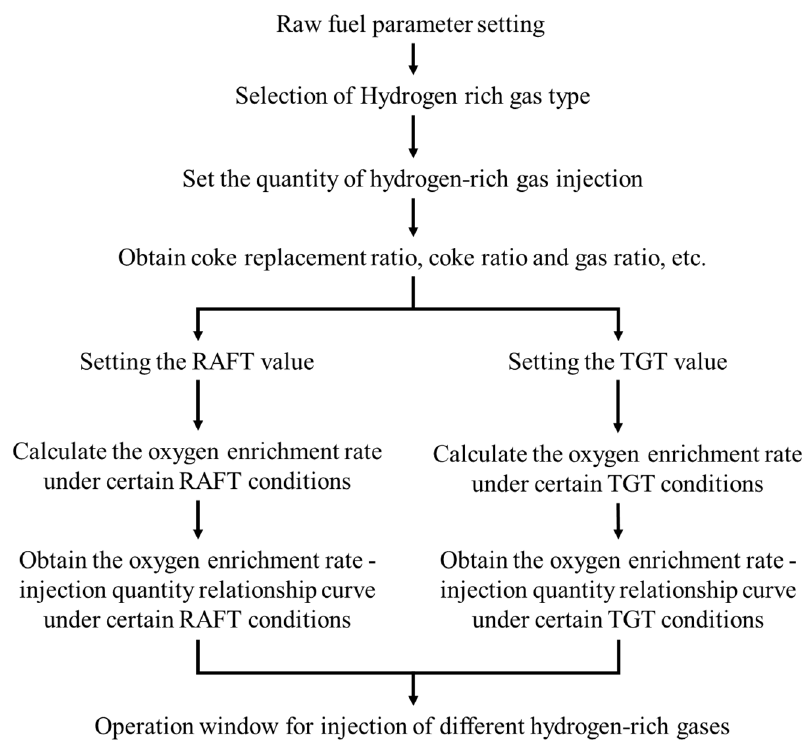
Figure 2. Calculation flow chart of blast furnace operation window.